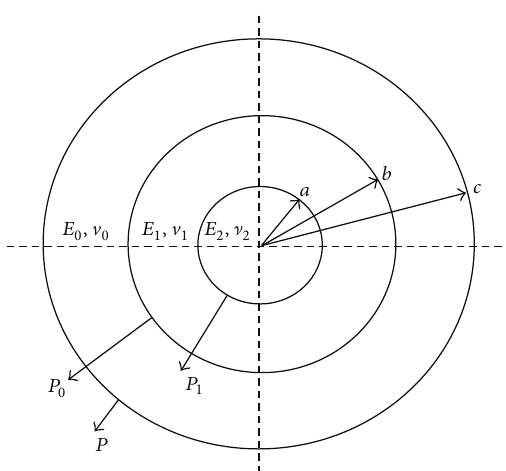
Figure 3: Microstructure model of elastic parameter